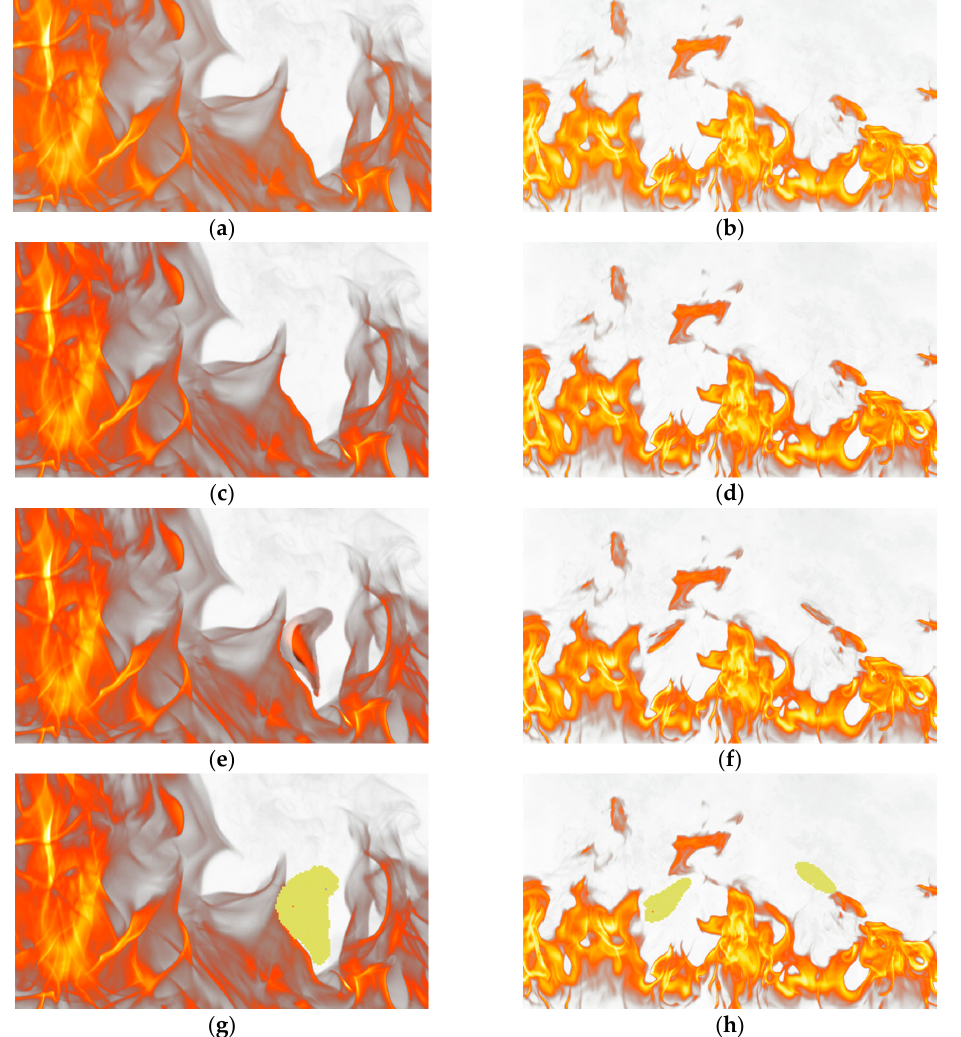
Figure 7. Examples of forging and detection. ( a , b ) original images with alpha channel (courtesy of and © Footage Firm, http://www.stockphotosforfree.com); ( c , d ) watermarked images, RGB channels untouched, PSNR 63.84 dB and 63.87 dB respectively; ( e , f ) tampered images; ( g , h ) images with tampered areas evidenced by the algorithm.